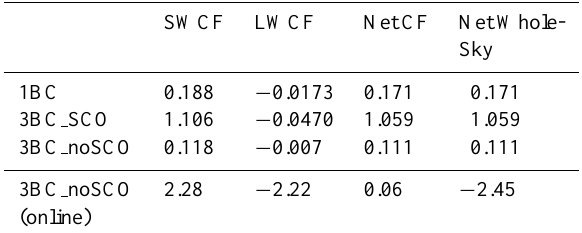
Table 3. Annual average anthropogenic cloud forcings (CF) and whole-sky forcings (Wm − 2 ). The line separates offline and on- line simulations. Offline forcings are for mixed-phase clouds, while online forcings include all effects: warm, mixed-phase, and cirrus clouds and direct